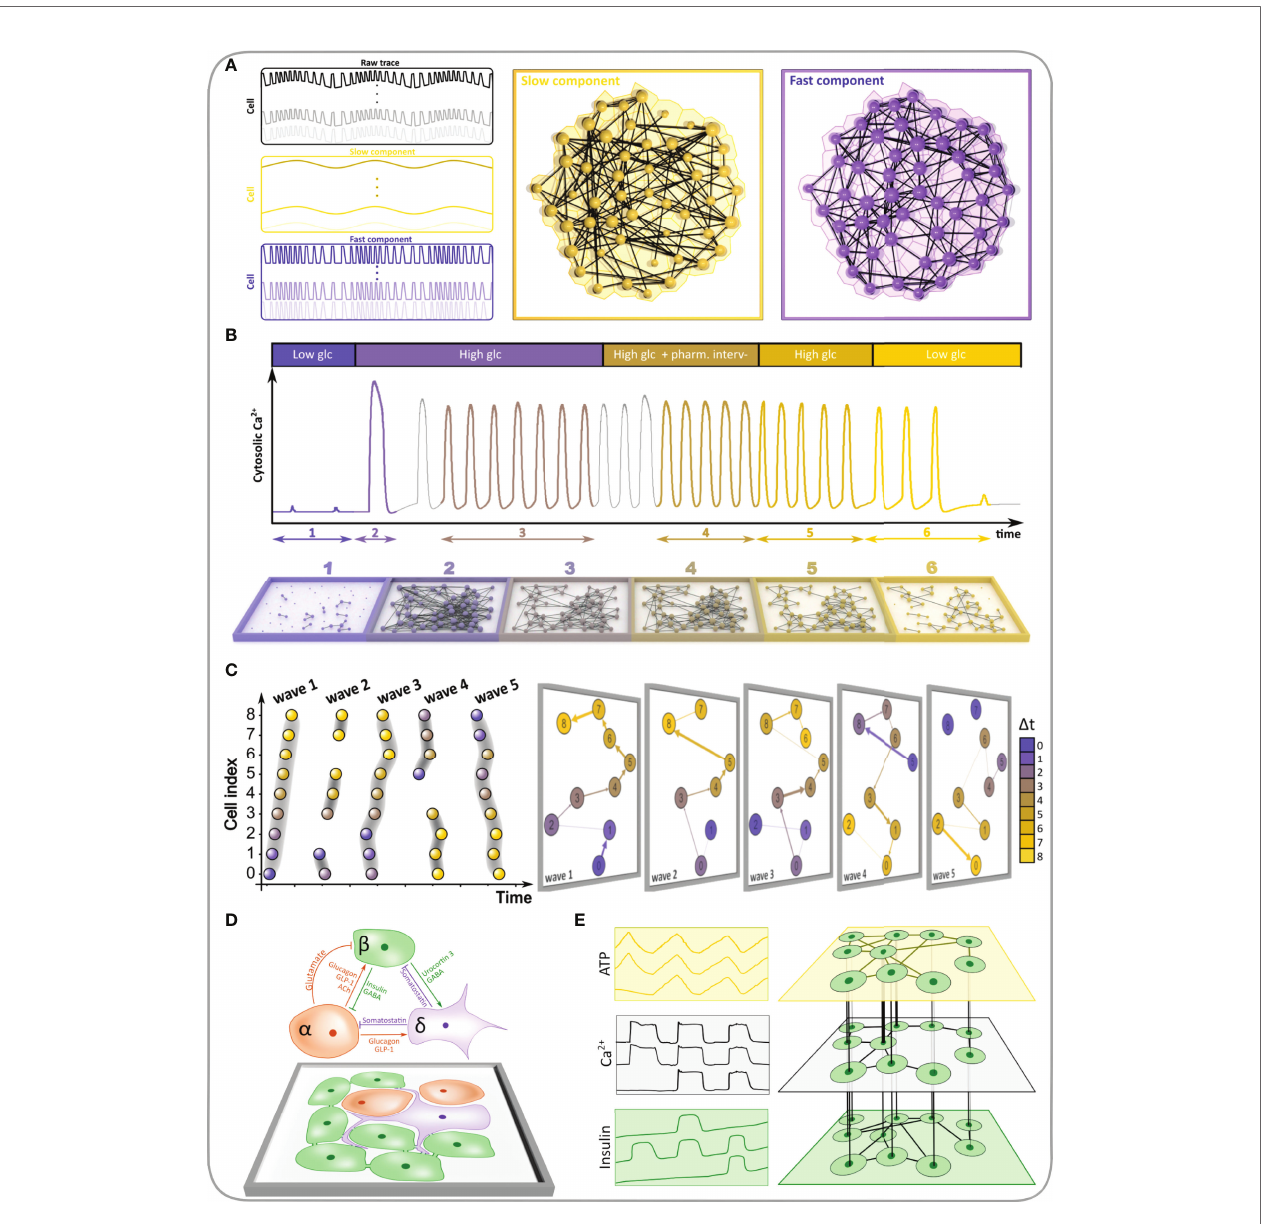
FIGURE 10 | The MLN formalism can be used to study various aspects of collective dynamics and cellular activity patterns within the pancreatic islets. (A) A hypothetical raw [Ca 2+ ] IC signal and the extracted slow and fast components (left panel). The two different oscillatory components are then used to construct a two-layered multiplex functional beta cell network (right panel). (B) Typical [Ca 2+ ] IC activity in a pancreatic islet subjected to a hypothetical protocol (upper panel) and the corresponding temporal functional network layers extracted from speci fi c time intervals (lower panel). (C) A schematic presentation of how network layers are designed from individual intercellular [Ca 2+ ] IC waves. The left panel features a raster plot indicating the onsets of oscillations of cells within speci fi c waves and the right panel visualizes the corresponding network layers. The direction and weights of connections within each layer denote the course and the temporal lag between subsequent oscillation onsets, respectively. (D) Heterologous and homologous interactions within the islets visualized as a multilayer network. (E) Hypothetical simultaneously measured dynamics of [Ca 2+ ] IC , intracellular ATP, and insulin release along with the corresponding functional network layers. Intralayer connections represent functional connections between time series of the same variables, whereas the interlayer connections stand for associations between different measured